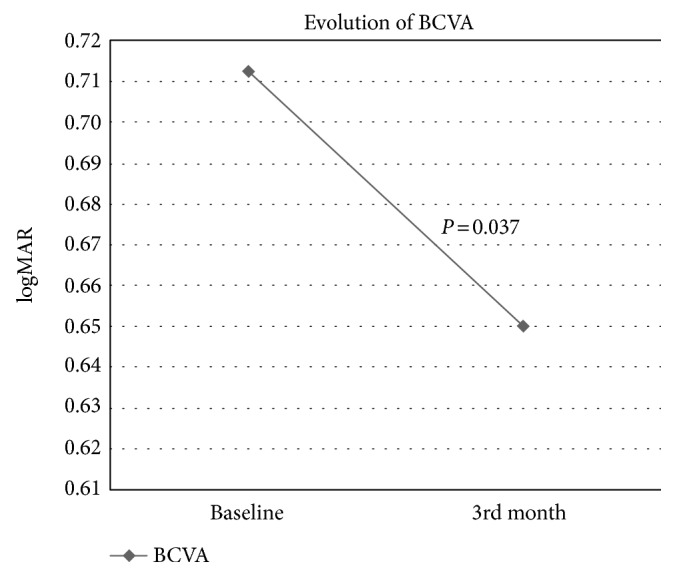
Evolution of BCVA.